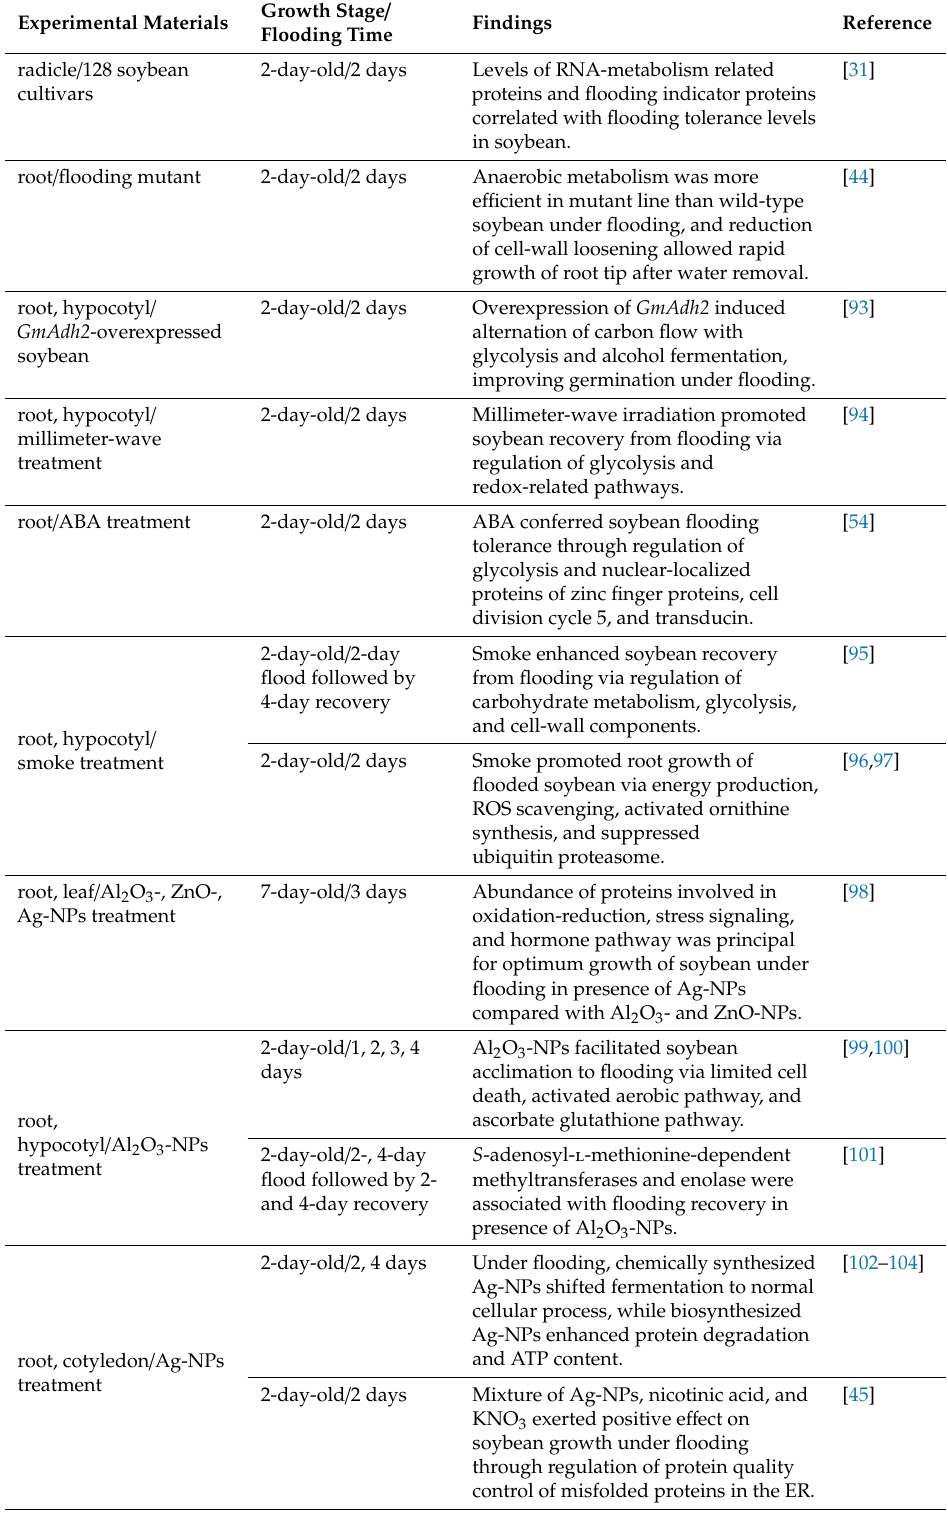
Table 2. Proteomic analysis to understand flood-tolerant mechanisms in